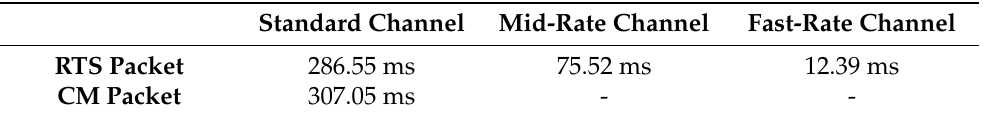
Table 1. ToA of each control packet.